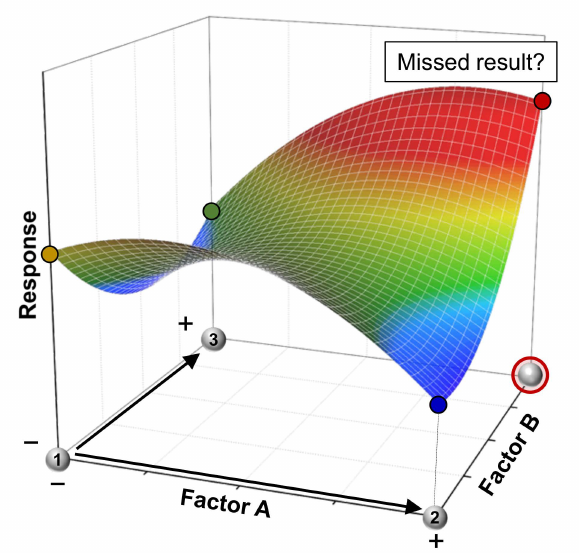
Figure 1. Strategic route of conventional OFAT experimentation. When interactions between factors are not revealed, a potential optimum might be